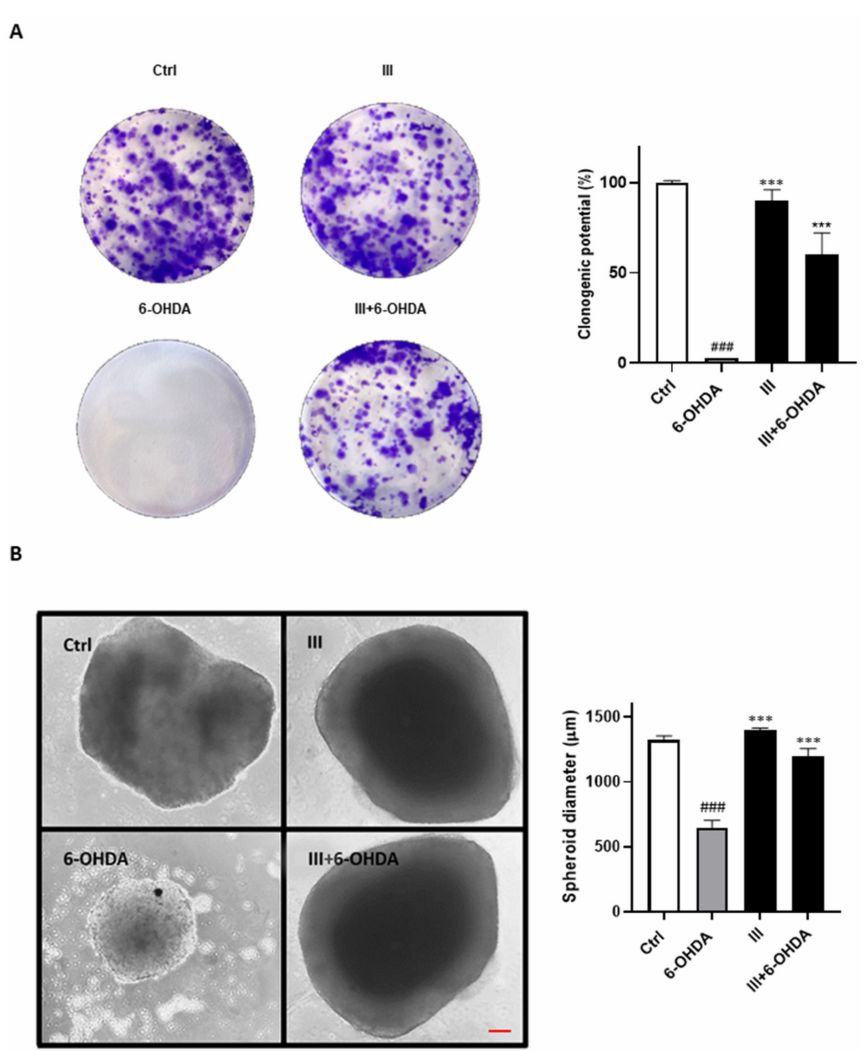
Figure 4. ( A ) Evaluation of neuroprotective effects of fraction III on SH-SY5Y clonogenic potential and ( B ) spheroids sizes. Scale bar: 100 µ m. Results are shown as mean ± standard deviation (SD) from three independent experiments. ### denotes p < 0.001 vs. Ctrl; *** denotes p < 0.001 vs.